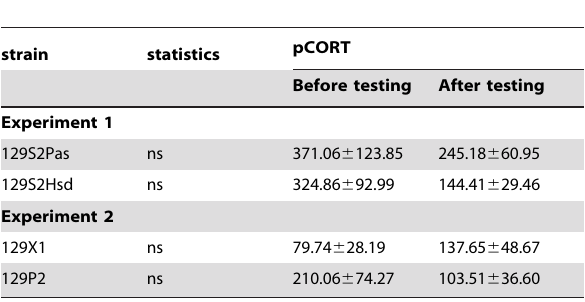
Table 1. Plasma corticosterone (CORT) levels before and after testing in both